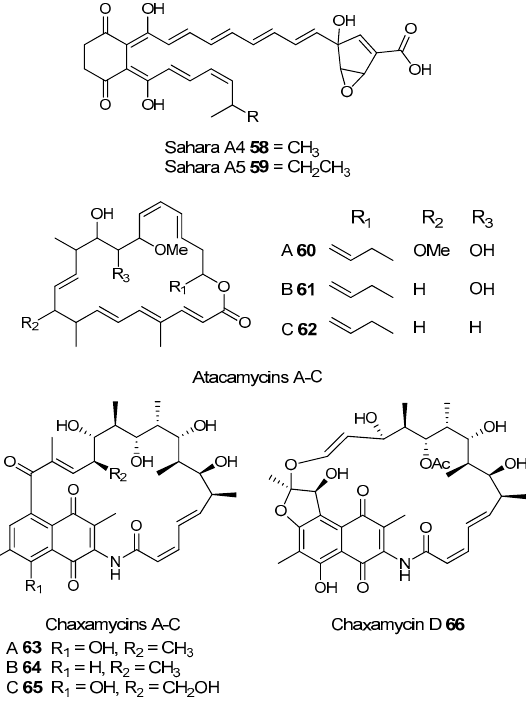
Figure 16. Natural products from desert isolates.